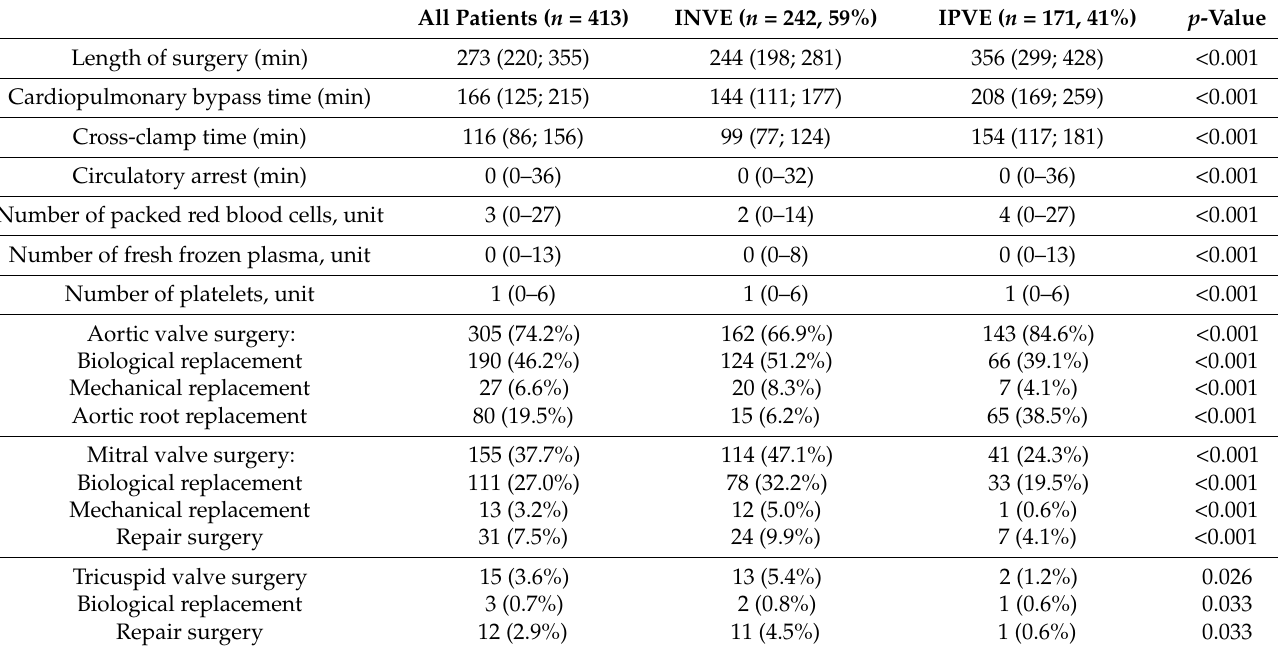
Table 2. Operative data.